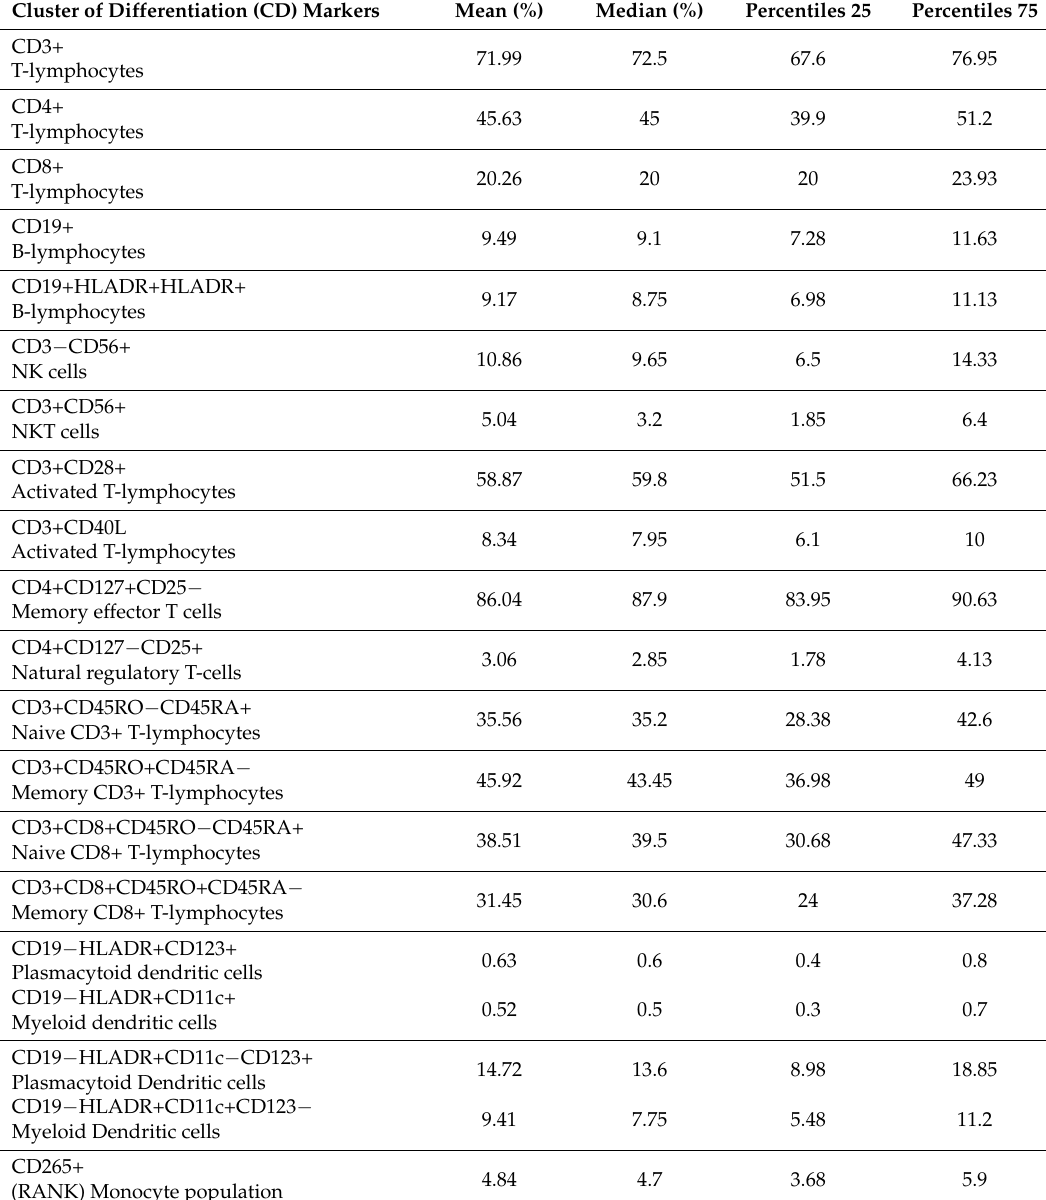
Table 1. Total cell surface expression and cell populations in blood samples from women. Cluster of Differentiation (CD)